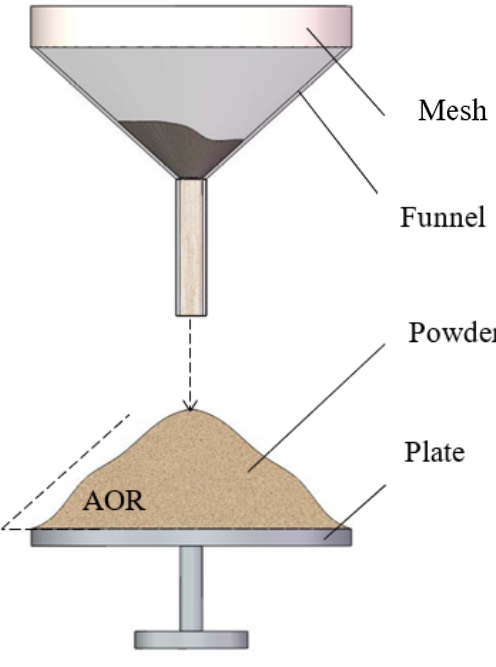
Figure 3. Schematic of AOR measurement.